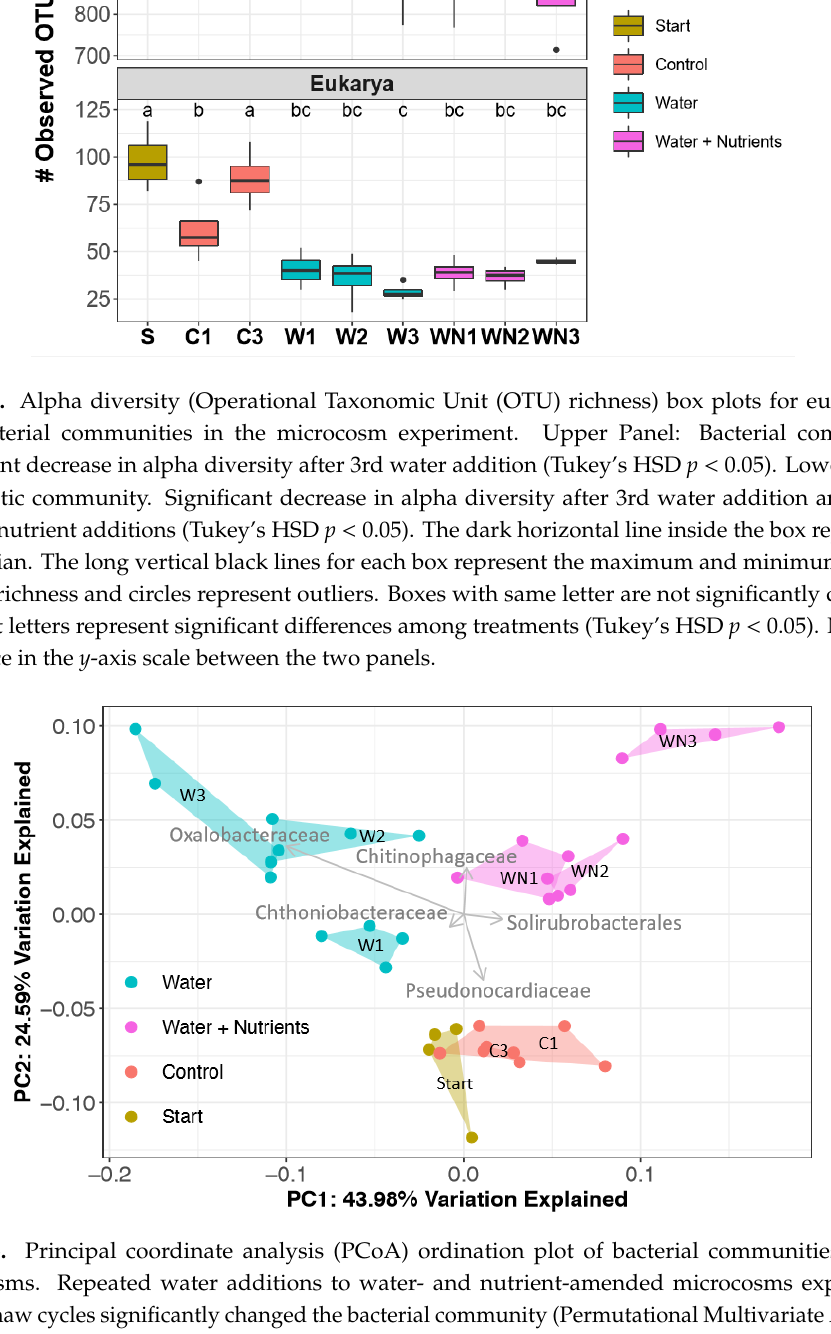
plained 0.1 Ex Figure 6. Principal coordinate analysis (PCoA) ordination plot of eukaryotic communities in soil microcosms. Repeated water additions to water- and nutrient-amended microcosms exposed to freeze–thaw cycles significantly changed the eukaryotic community (PERMANOVA p < 0.001, R 2 = 0.75). The vector length is proportional to the correlation between the PCoA axes and the OTUs that contributed most to the observed dissimilarity among treatments (SIMPER). Communities became increasingly different from controls following multiple amendments. −0.2 −0.1 0.0 −0.3 −0.2 −0.1 0.0 0.1 PC 1: 38.67% Variation Explained PC2: 32.95% Varia tion Water Water + Nutrients Control Start Neochlorosarcina sp.